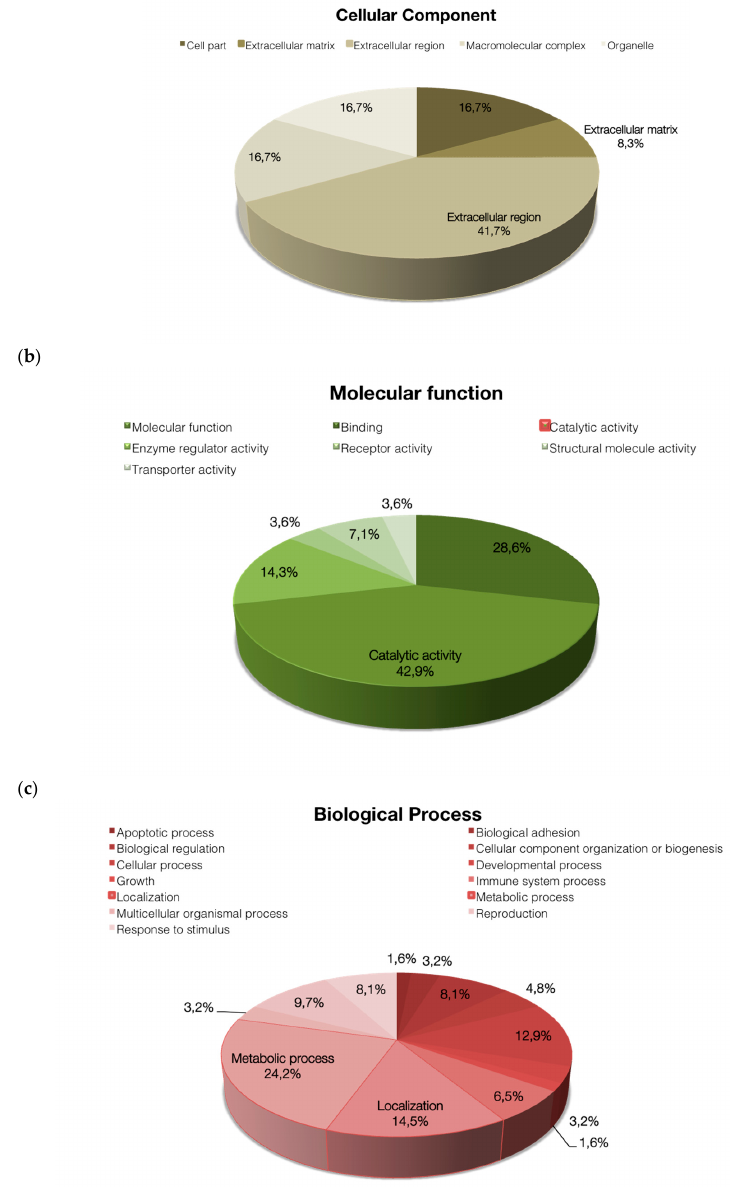
Figure2. Classificationofthedi ff erentialproteinsaccordingtotheir( a )cellularcomponent, ( b )molecular function, and ( c ) biological process, by using the information available at the Panther Web